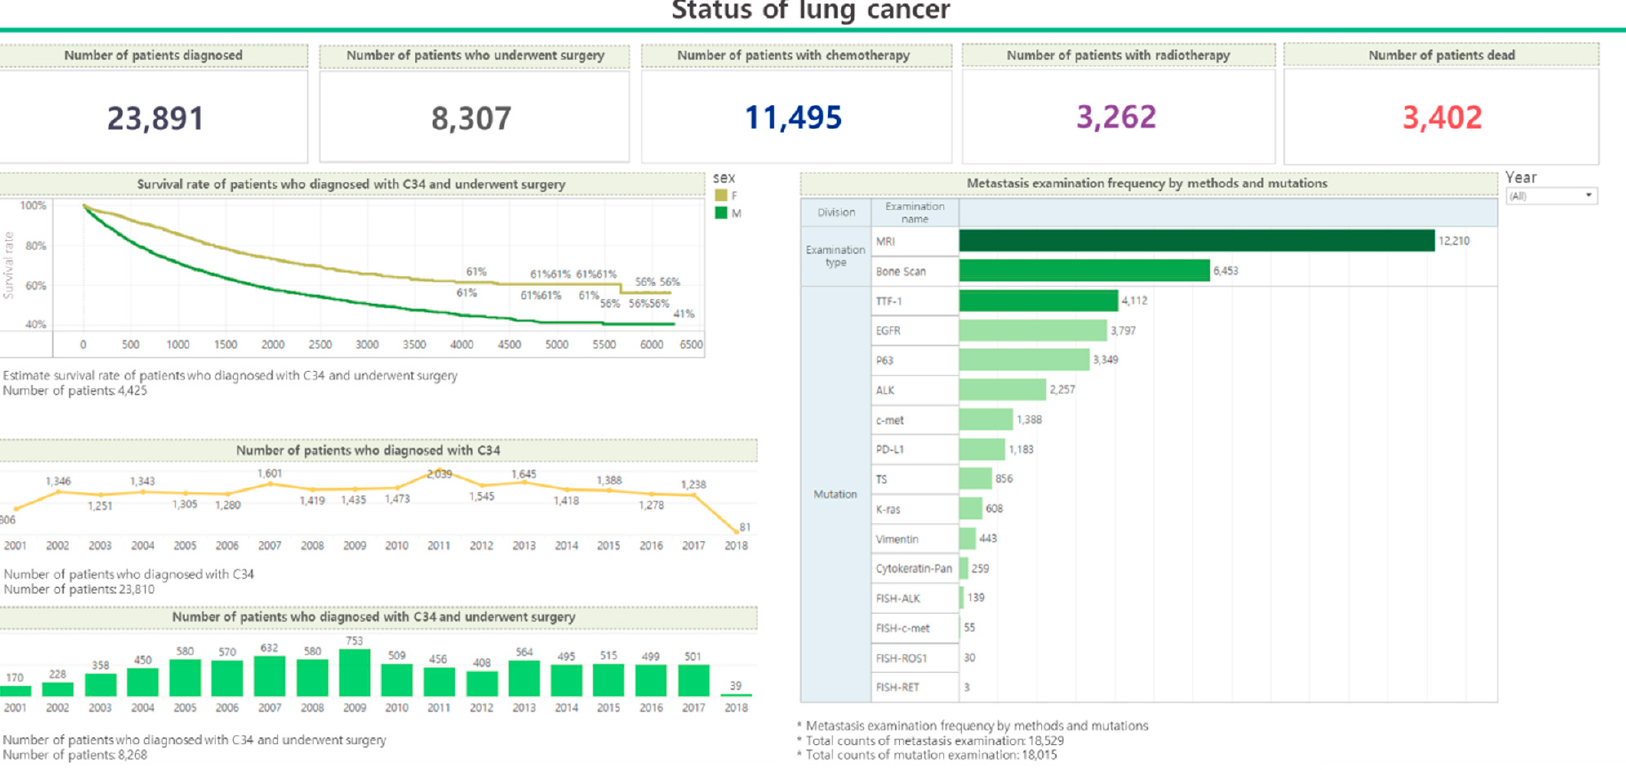
Figure 5. A screenshot of the Korea Cancer Big Data Platform (K-CBP) clinical cancer registry website showing the summary statistics for lung cancer as of December 2018.